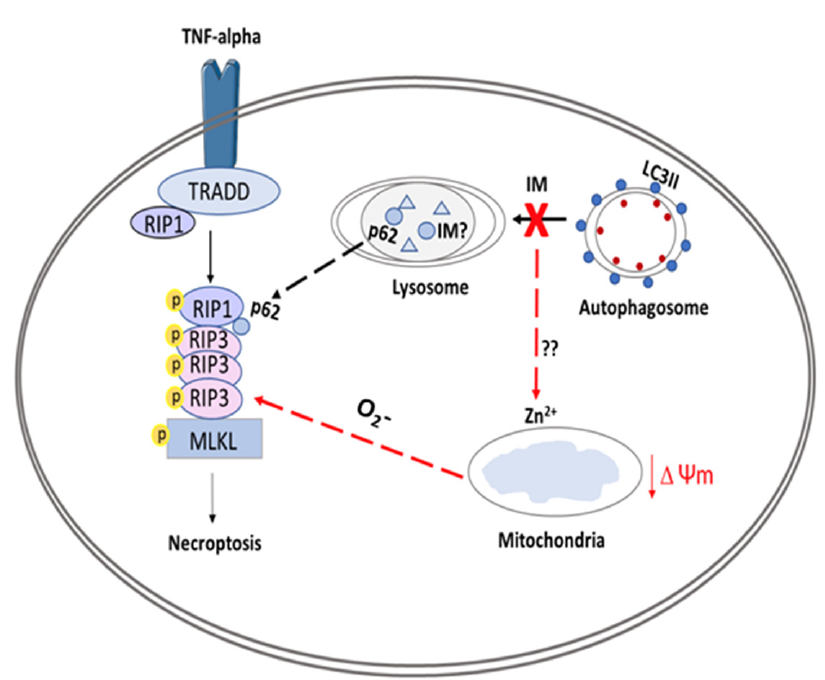
Figure 8. Schematic overview of proposed model for IM-induced cell death in CPCs. The figure shows IM being sequestered by the lysosomes, causing an impaired autophagic flux. This abnormal flux causes the release of zinc ions, which affect the ∆ ψ m, leading to production of superoxides (O 2 -); these superoxide ions can help to form the ripoptosome. The ripoptosome formation is also aided by leakage of p62 proteins from lysosomes and autophagosomes. Finally, the ripoptosome formation causes the activation/phosphorylation of MLKL and initiates necroptotic cell